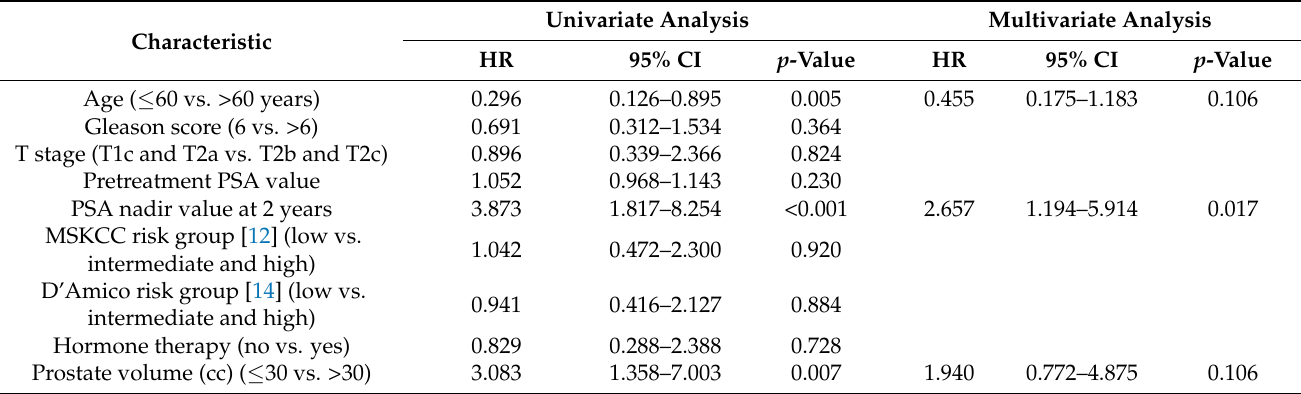
Table 2. The prognostic factors associated with PSA